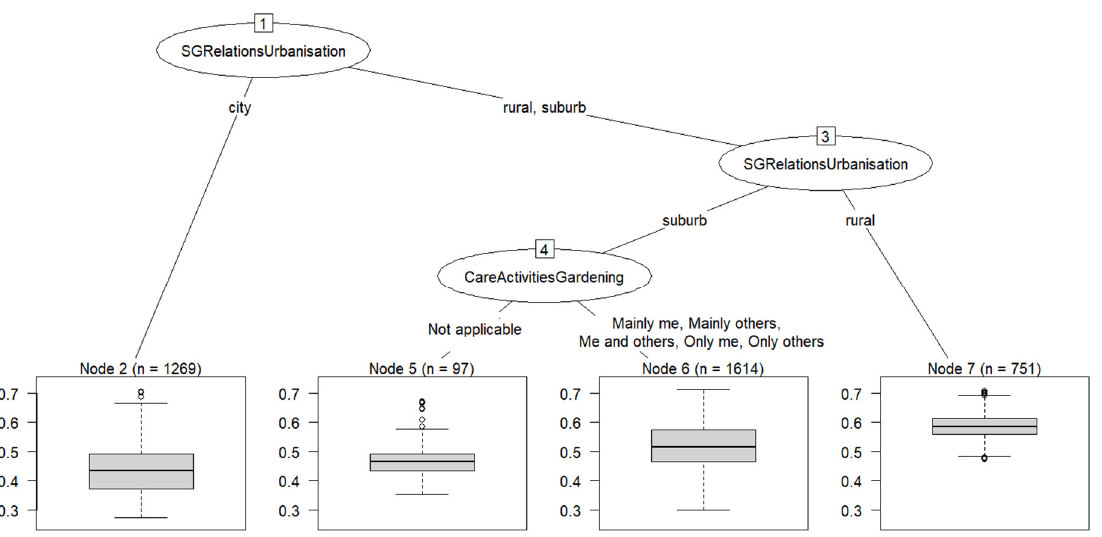
Figure 3. CART tree for the exposure measure greenness within a 1000 m buffer around the residential address (objectively measured). Boxplots in the bottom row show the distribution of the NDVI values in each subgroup.